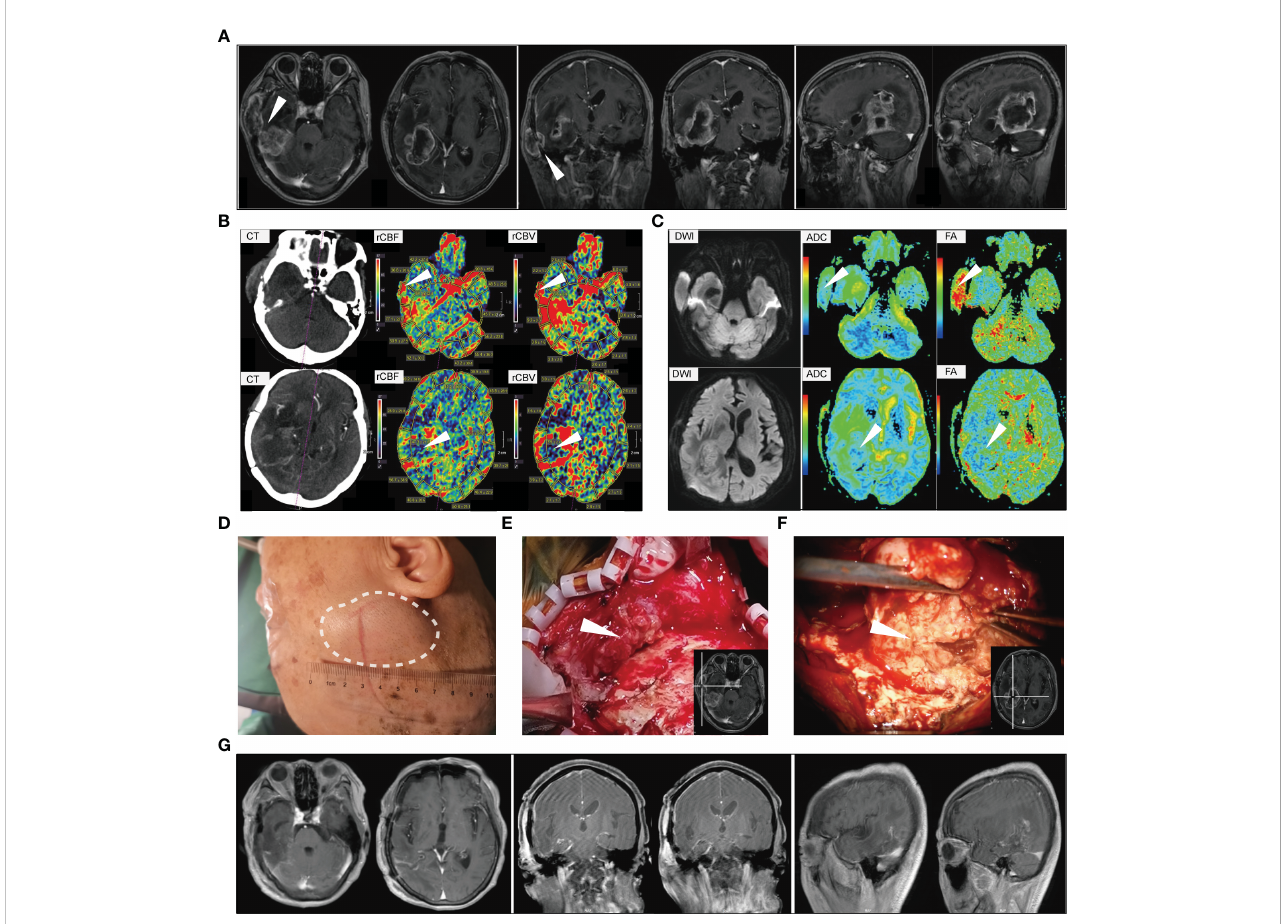
FIGURE 1 The serial perioperative imaging and tumor characteristics at second surgery. (A) The preoperative magnetic resonance imaging. White arrows indicate that the extracranial tumor is directly connected to the intracranial tumor via the channel of craniotomy defect. (B) The relative cerebral blood fl ow/ volume maps based on CT perfusion images. White arrows indicate that the blood supply was signi fi cantly higher in the core region of extracranial tumor compared to the core region of intracranial tumor. (C) Corresponding apparent diffusion coef fi cient (ADC) and fractional anisotropy (FA) maps of the patient. (D) The scalp lesion before resection. (E) Representative image of the subcutaneous tumor. The white arrow indicates the core region of extracranial tumor. (F) Intraoperative picture under a surgical microscope. The white arrow indicates the core region of the intracranial tumor. (G) The postoperative magnetic resonance imaging (1 week after